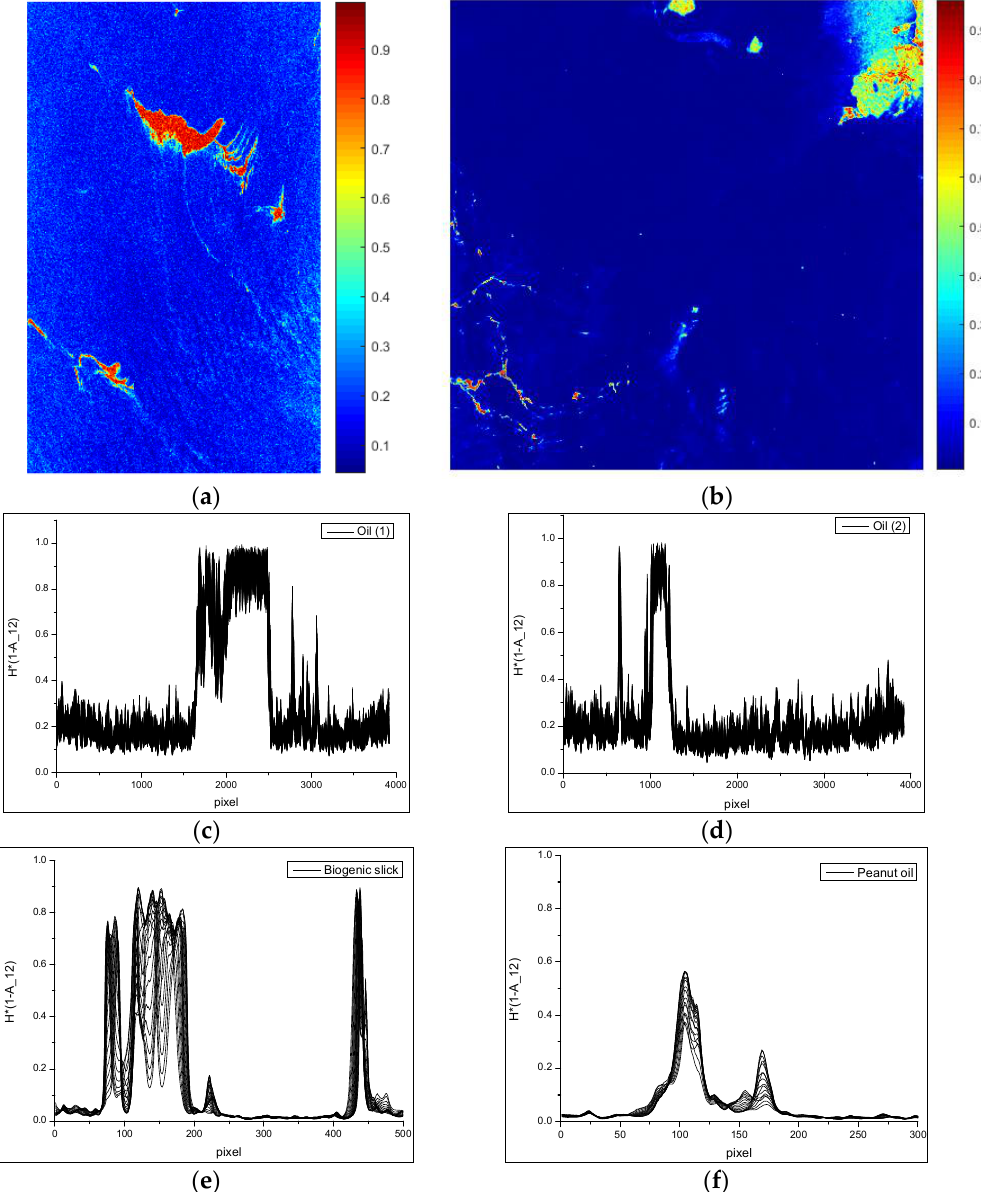
Figure 8. H *(1 − A 12 ) value for the two continuously slow-release slicks cases mentioned above: ( a ) Case 1; ( b ) Case 2; ( c – f ) the modified H *(1 − A 12 ) for the four green rectangular areas (oil (1), oil (2), biogenic slick, and peanut oil, respectively) that are indicated on the SAR images in Figures 2 and